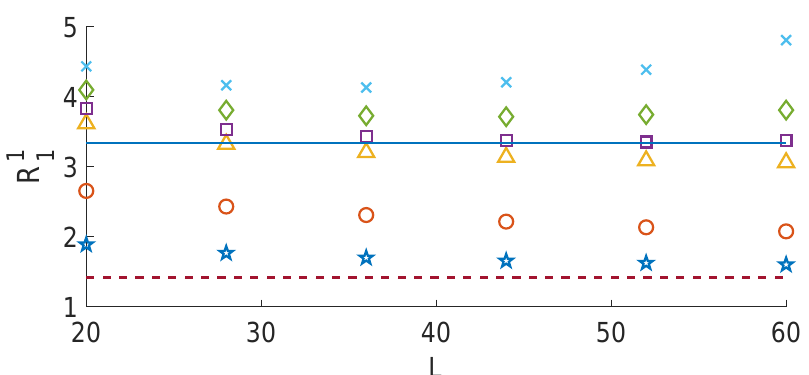
= − 1 to illustrate the termination of the 1 = − 0.6 (blue stars), − 0.65 (red circles), − 0.67 P